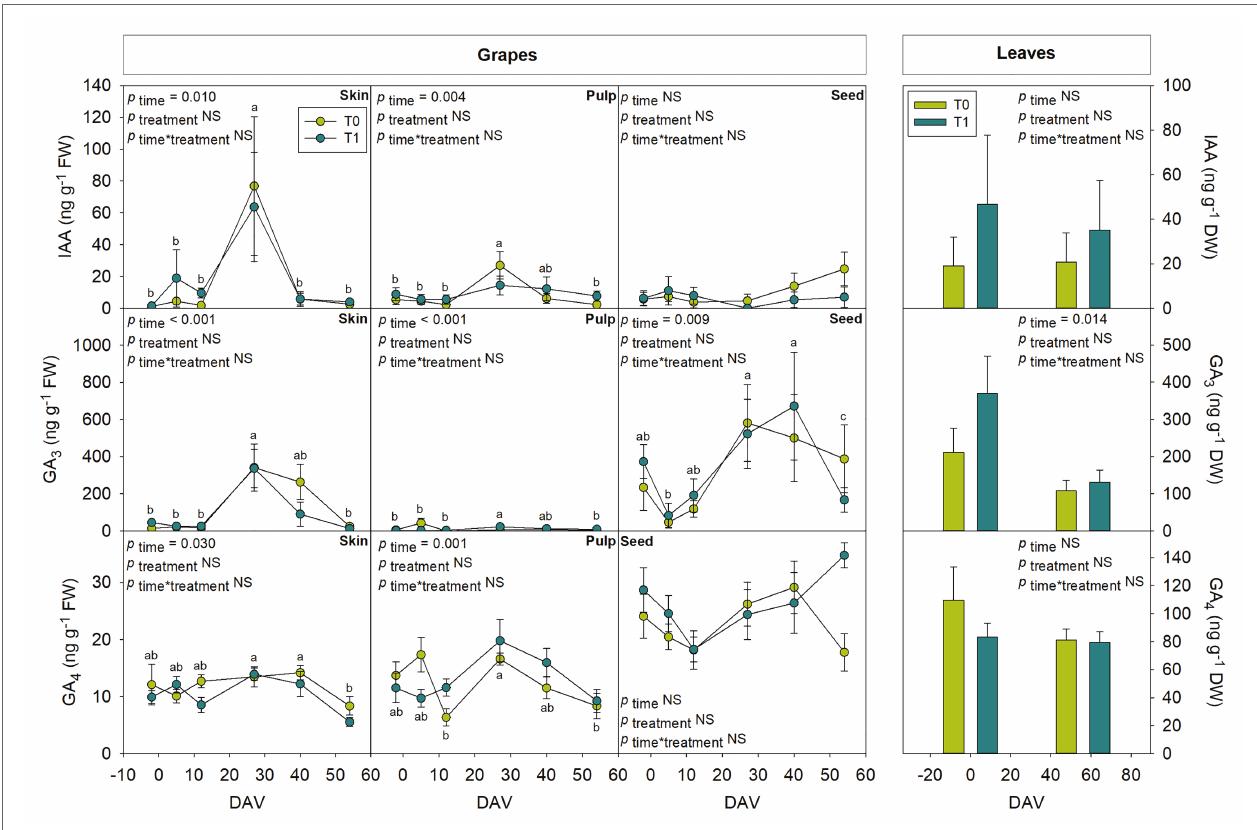
FIGURE 7 | Tissue-specific endogenous variations in auxin and gibberellins in berries of “Merlot” grapes during ripening in non-irrigated (T0) and irrigated (T1) vineyards. Indole-3-acetic acid (IAA), GA3, and GA4 contents in grape tissues, including the skin, pulp and seeds throughout ripening are shown. Hormonal contents in leaves at the beginning and the end of the season are shown for comparison. Vertical bars indicate SE of six replicates. Different letters denote significant differences among sampling dates (Tukey’s HSD post-hoc test p < 0.05). The asterisks indicate statistically significant differences between treatments ( p <